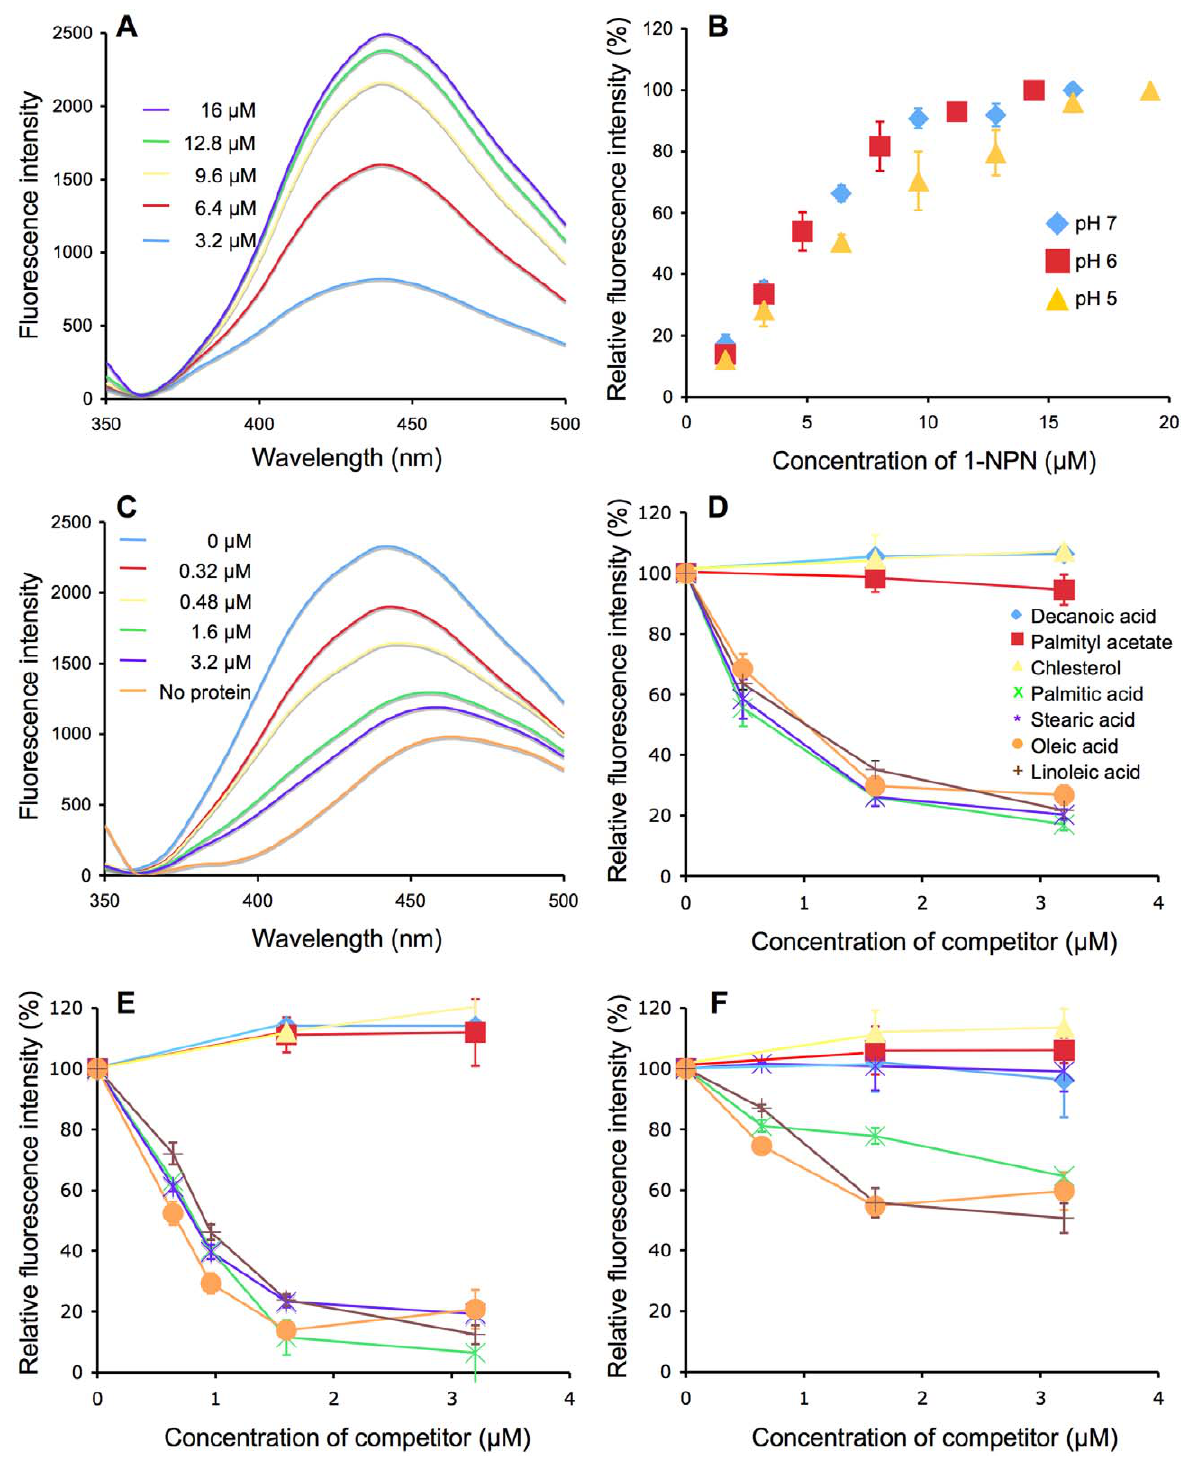
Figure 5. Binding of PregOBP56a to N -phenyl-1-naphthylamine (1-NPN) and potential ligands derived from chicken meat. A, A typical emission spectra following the addition of 1-NPN (3.2–16 m M final concentration) to recombinant PregOBP56a (10 m g/ml of 20 mM phosphate-citrate buffer, pH 7). The emission spectra were generated following excitation at a wavelength of 337 nm. B, Binding of 1-NPN to PregOBP56a at pH 7, 6, and 5. In these experiments PregOBP56a (10 m g/ml) was incubated with various concentrations (1.6–19.2 m M) of 1-NPN and emission at 440 nm was plotted. Values are means 6 standard deviation, n=3. C, Typical emission spectra following the addition of a competitor to PregOBP56a bound to 1-NPN. PregOBP56a (10 m g/ml) in 20 mM phosphate-citrate buffer at pH 7 was pre-incubated with 16 m M of 1-NPN (final concentration). Then, palmitic acid (0–3.2 m M final concentration) was added to the reaction, and the emission spectra (excitation a wavelength of 337 nm) were recorded. D, Binding of PregOBP56a to various ligands at pH 7. For each set of data, fluorescence values at a wavelength of 440 nm were plotted as percent of that obtained in the absence of the competitor. Values are means 6 standard deviation, n=3. The competitors are shown